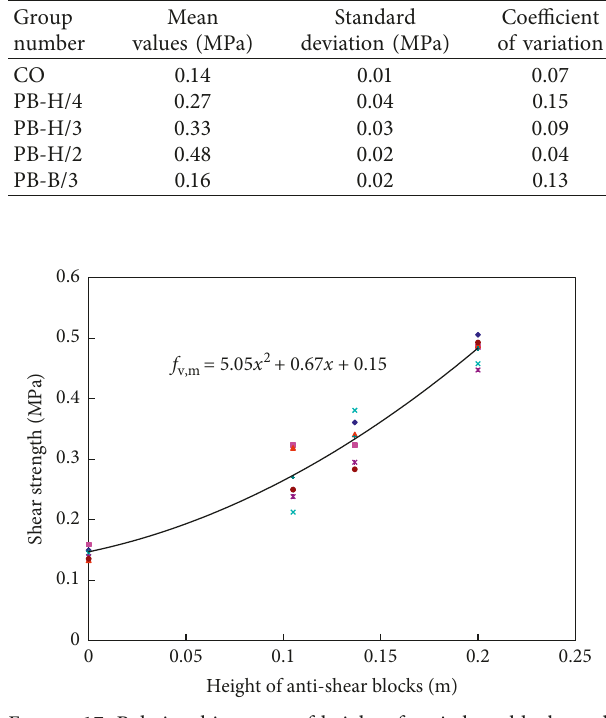
Figure 17: Relationship curve of height of anti-shear blocks and shear